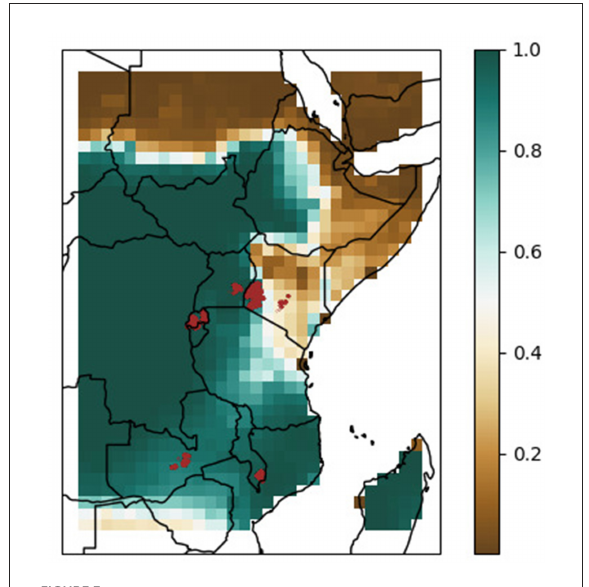
FIGURE3 Climatological water requirement satisfaction index (WRSI) calculated for variable planting dates throughout Africa. On the figure, WRSI is calculated for the planting date that results in the highest climatological WRSI (averaged over 15 years). The red circles indicate localities for which yield and planting date observations were